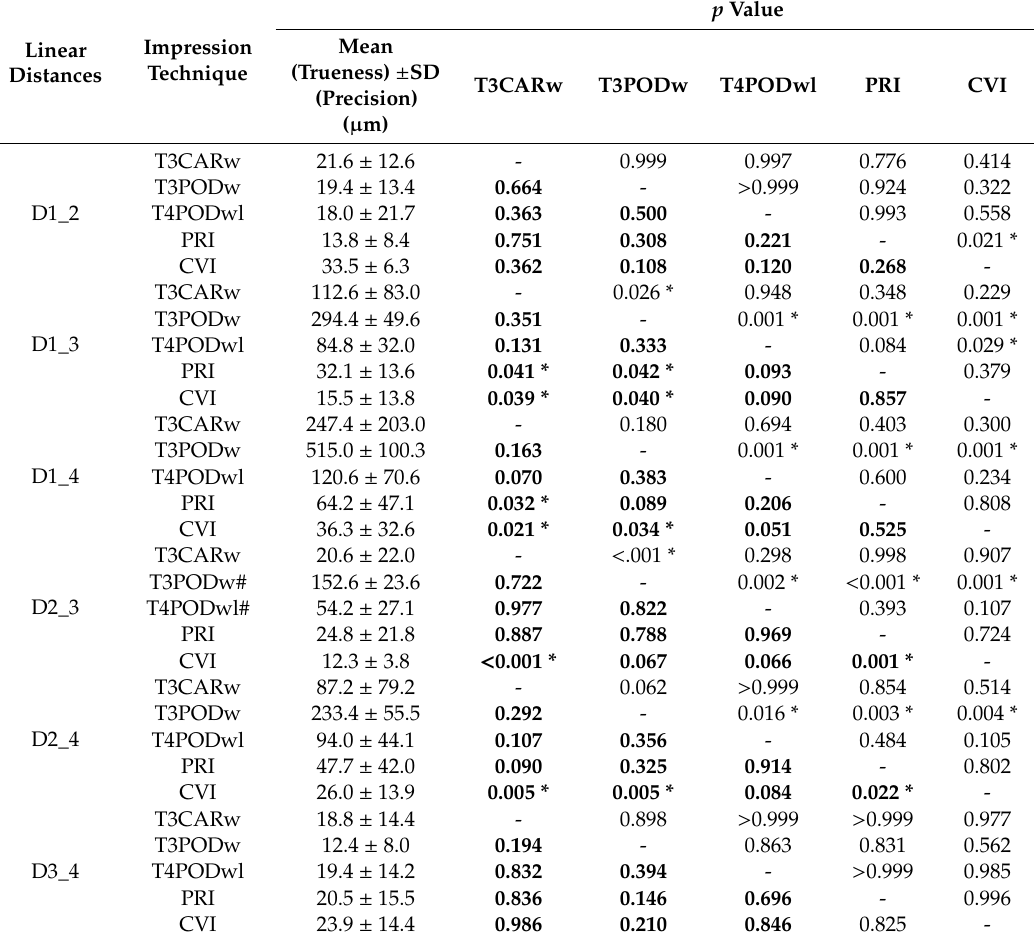
D2_3, D2_4, D3_4) and statistical analysis for trueness (upper right part) and precision (presented in